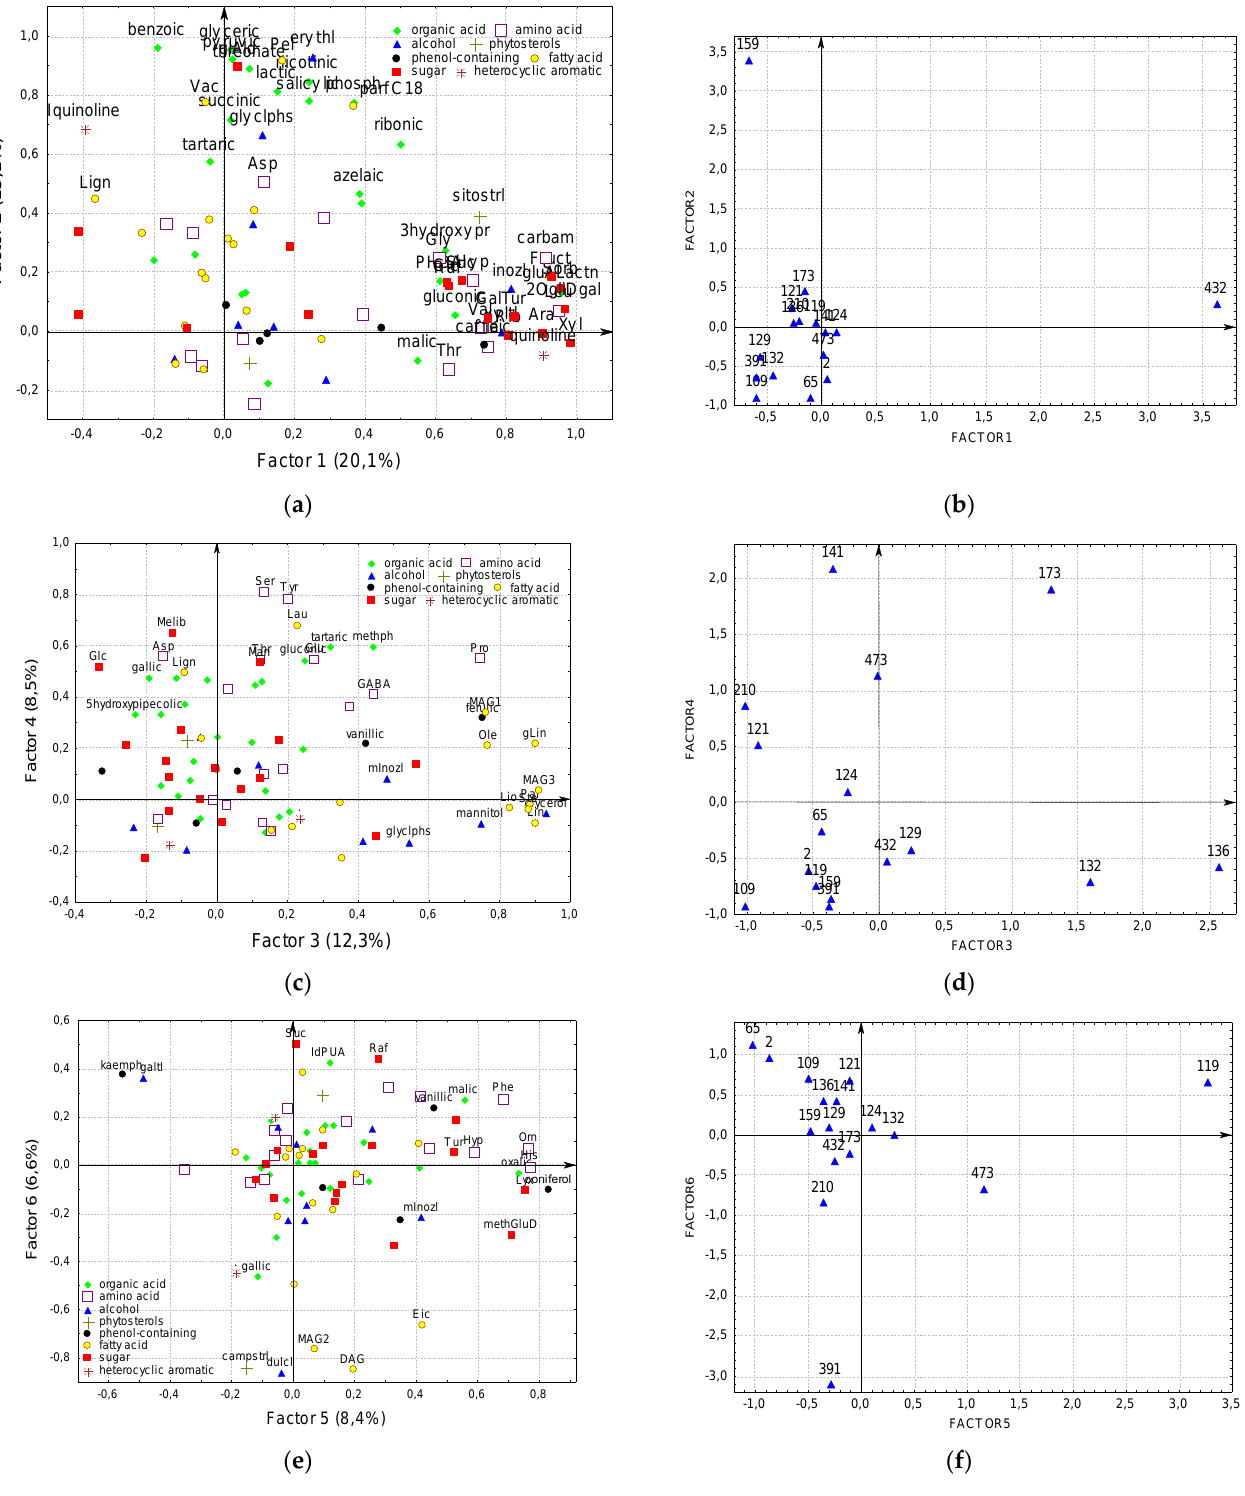
Figure 4. Factor analysis of flax metabolomic profile for 90 substances and 16 lines. ( a ) Factor 1 and Factor 2 system for substances; ( b ) Factor 1 and Factor 2 system for lines; ( c ) Factor 3 and Factor 4 system for substances; ( d ) Factor 3 and Factor 4 system for lines; ( e ) Factor 5 and Factor 6 system for substances; ( f ) Factor 5 and Factor 6 system for lines.